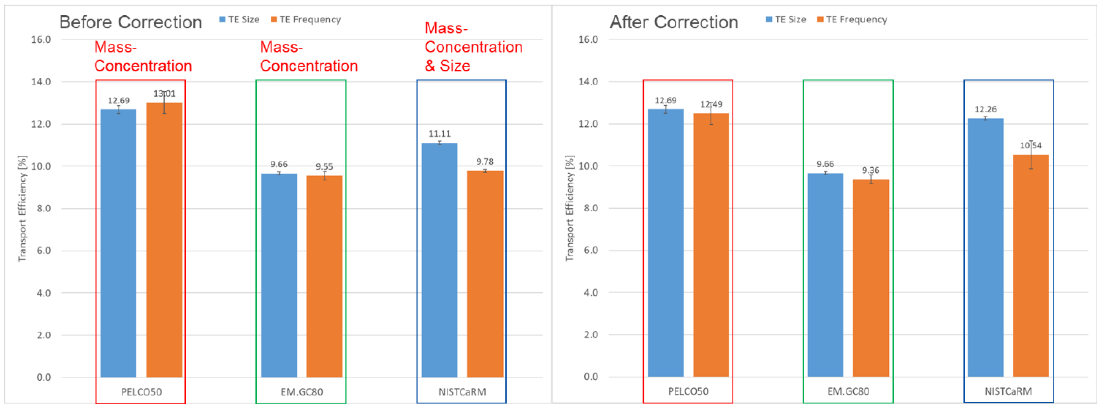
Figure 9. Transport efficiencies before and after correction for mass concentration and particle size. for mass concentration (around 50 mg L −1 ) and size (around 60 nm) were suggested. More